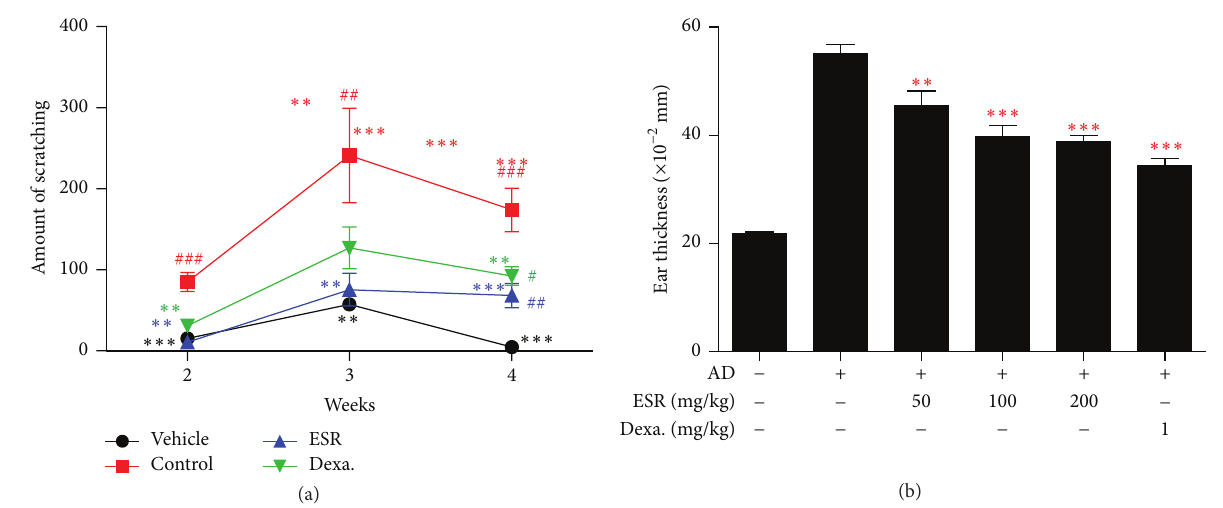
Figure 2: Effects of ESR on scratching behavior and ear thickness in AD mouse skin lesions. (a) Experimental induction of AD mouse skin lesions. (b) Ear thickness was measured with a dial thickness gauge. Results are expressed as the mean ± standard error of the mean (SEM) ( 𝑛 = 5 ). Vehicle, negative control; control, DNCB + vehicle; ESR, DNCB + 200mg/kg ESR; Dexa., DNCB + 1mg/kg dexamethasone treated group. # 𝑝 < 0.05 , ## 𝑝 < 0.01 , and ### 𝑝 < 0.001 versus vehicle; ∗∗ 𝑝 < 0.01 and ∗∗∗ 𝑝 < 0.001 versus